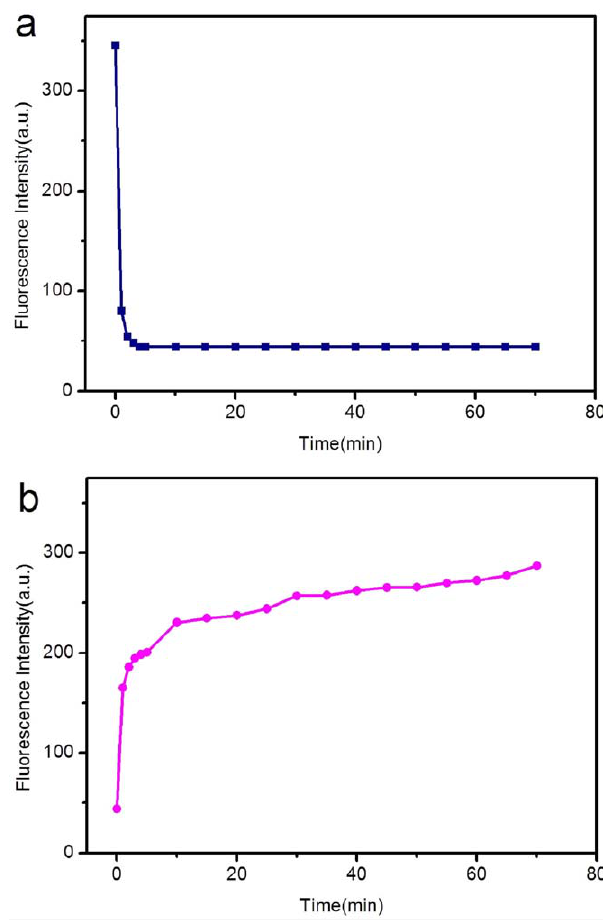
Figure 4. Kinetic behaviour study of fluorescence quenching and recovery at different temperatures. (a) Fluorescence quench- ing of P HIV (50 nM) by RCPNs and (b) fluorescence recovery of P HIV -RCPN by T 1 (300 nM) as a function of incubation time. Excitation was at 480 nm, and the emission was monitored at 518 nm. All measurements were done in Tris-HCl buffer in the presence of 15 mM Mg 2 + (pH: